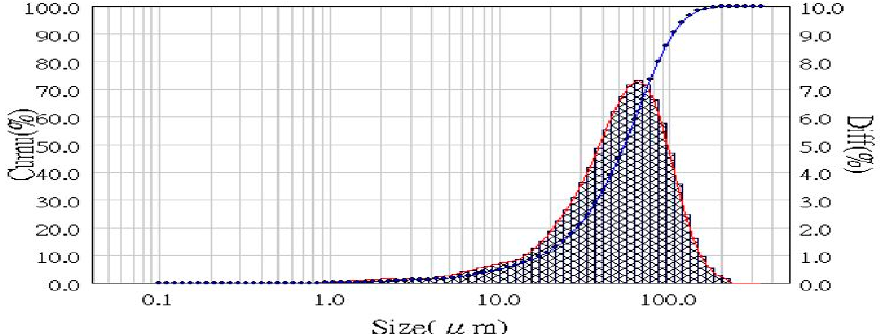
Figure 5. Particle size of the GaN waste by particle size distribution analyzer after ball milling.